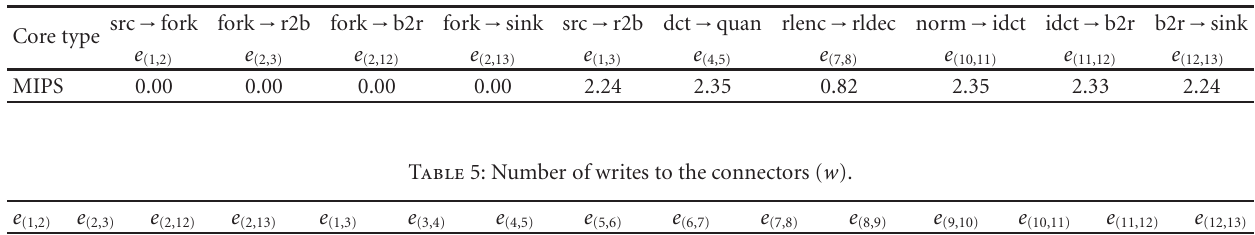
Table 4: Execution times (in ms ) of MWSender and MWReceiver tasks for each connector.